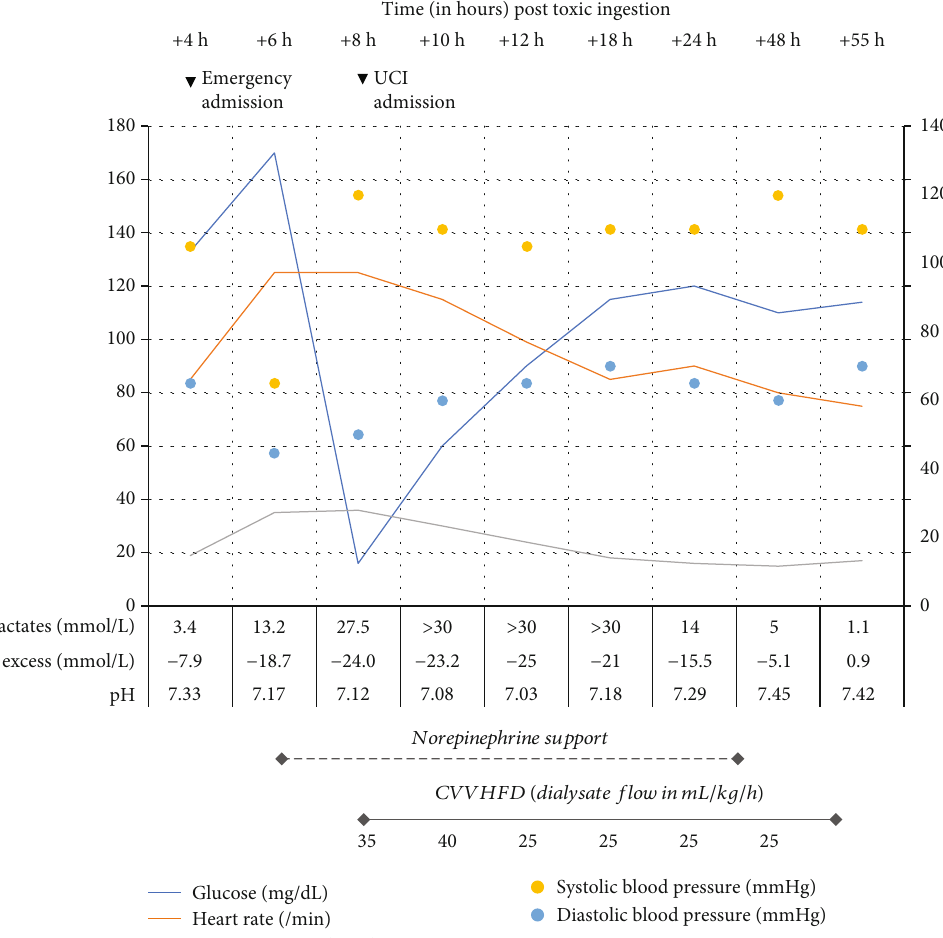
Figure 1: Physiological and biological